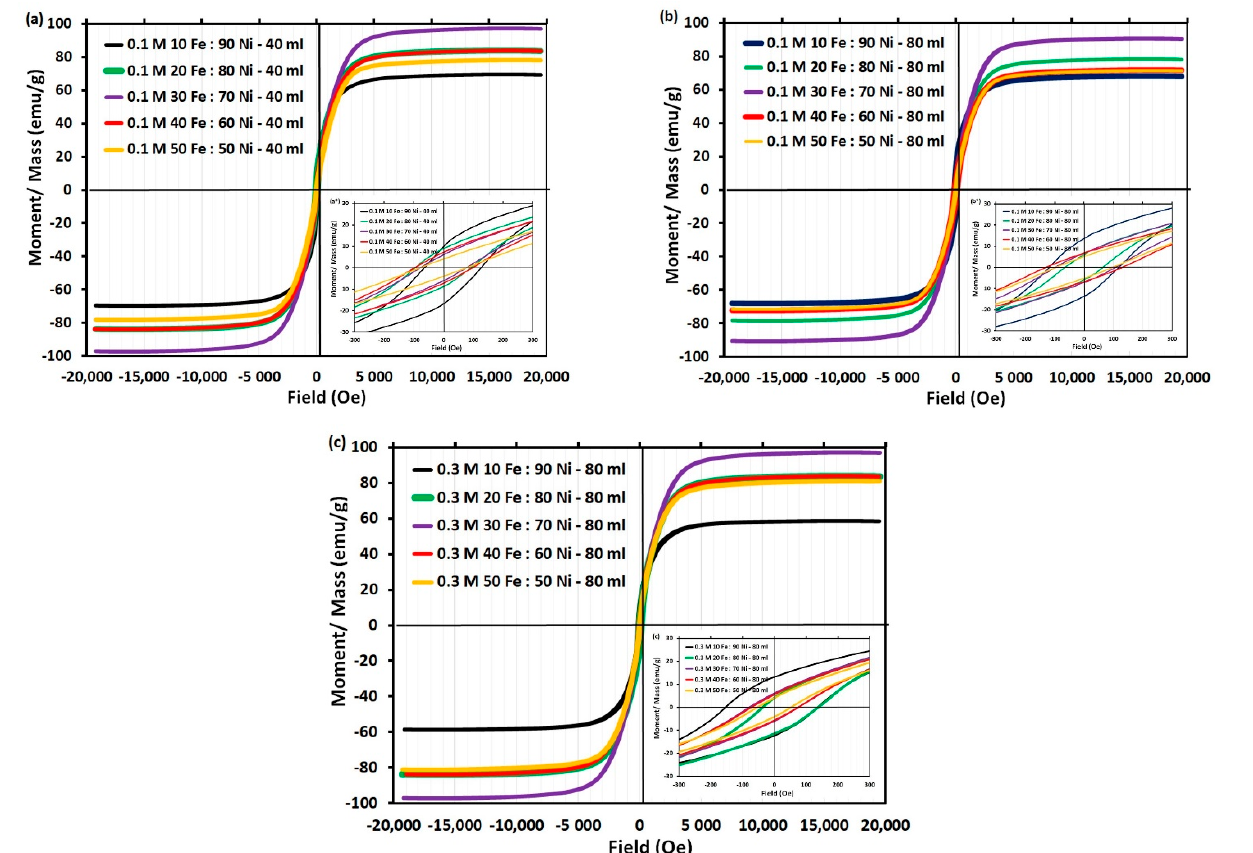
Figure 10. The M-H hysteresis loops of the iron-nickel microcrystals at room temperature; ( a ) 0.1 M metal concentration in 40 mL reaction volume, ( b ) 0.1 M metal concentration in 80 mL reaction volume, and ( c ) 0.3 M metal concentration in 80 mL reaction solution. Reaction reference: 1400 rpm and 95–98 °C.